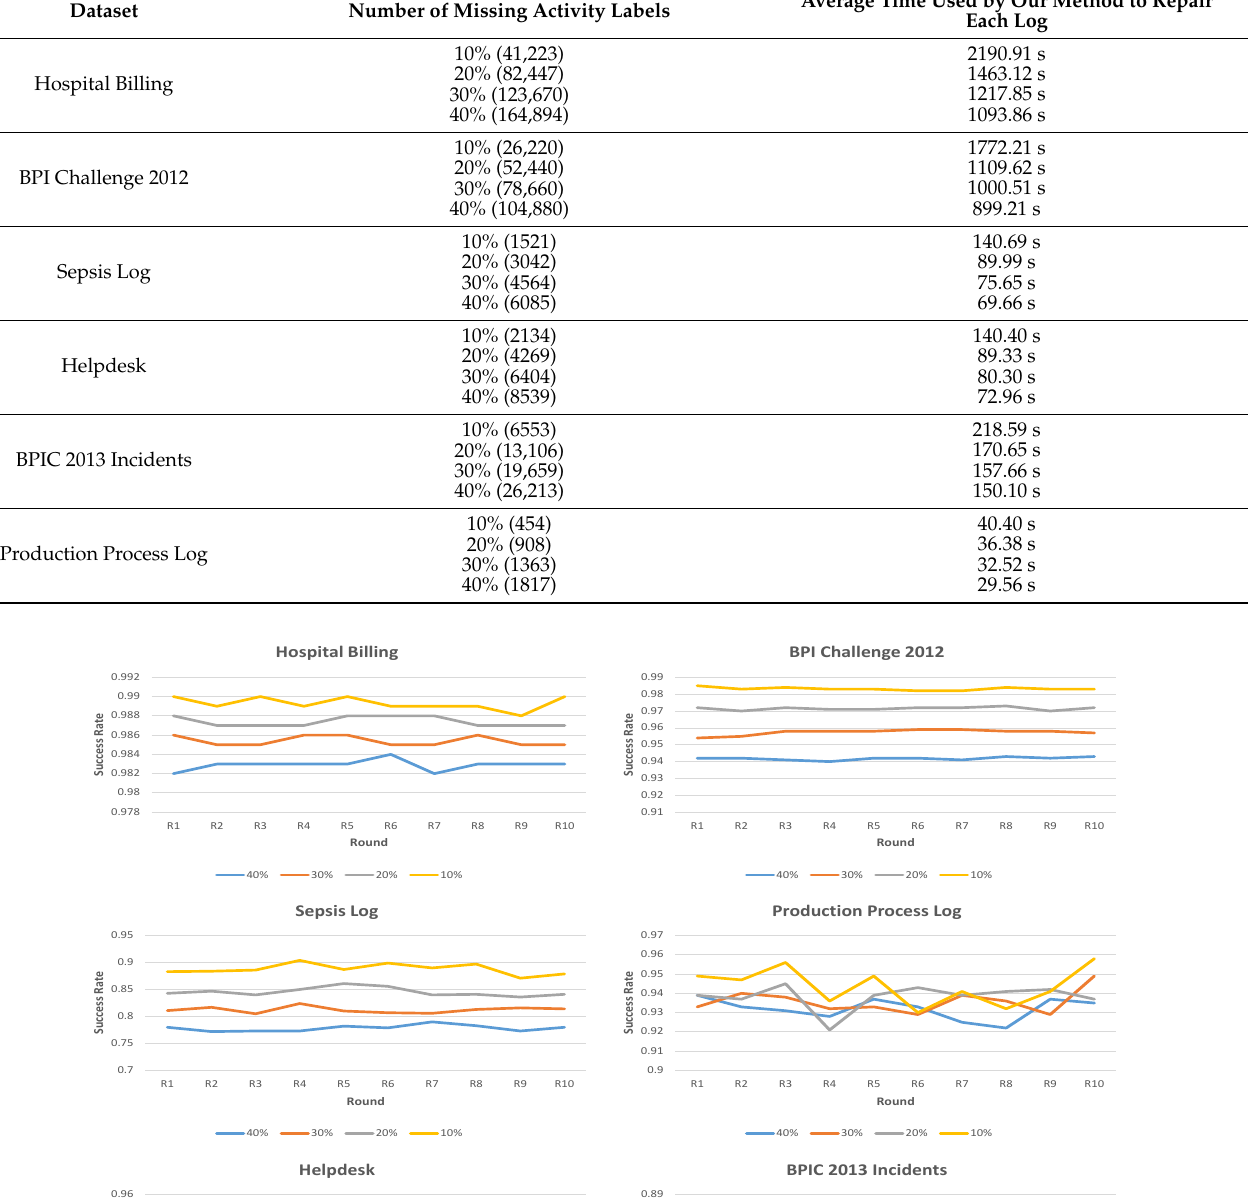
Table 9. Average time used to repair each log.